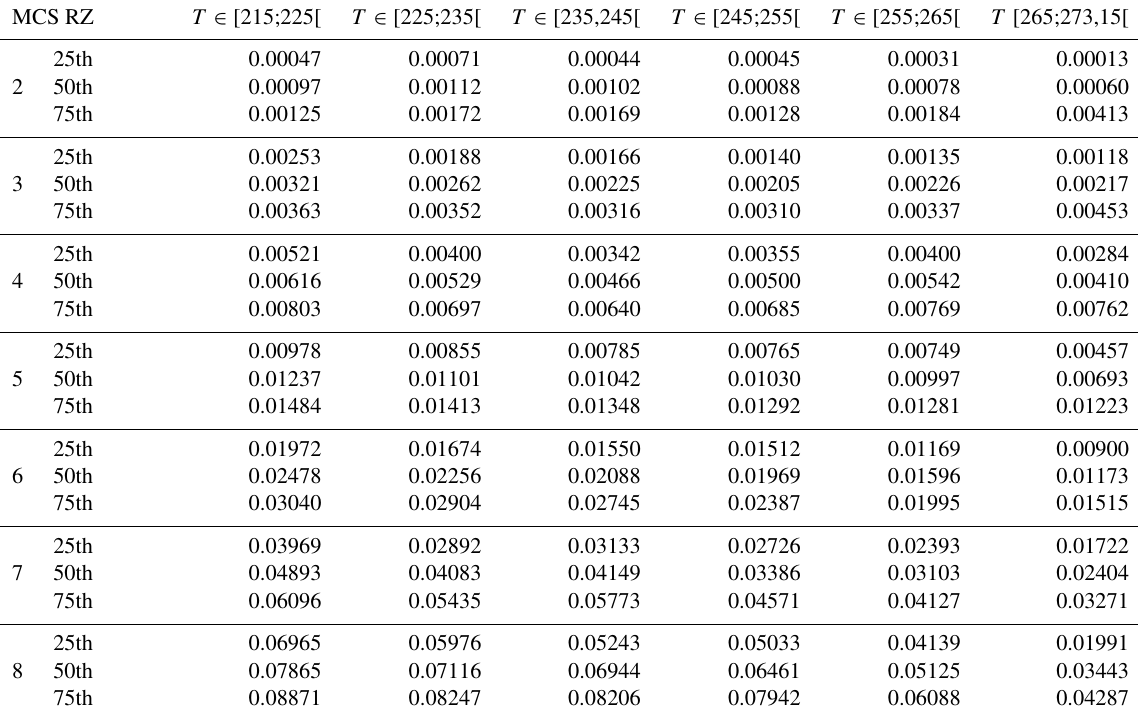
Table C3. Visible extinction ( σ ) in m − 1 (Fig.